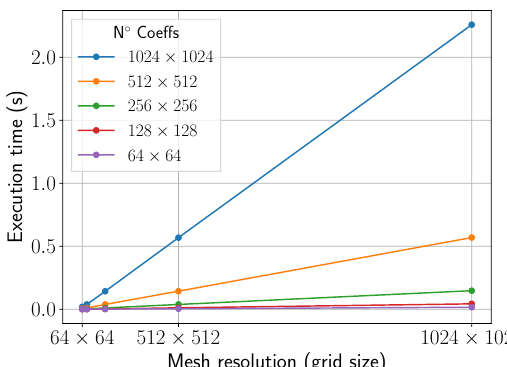
Figure 10. Execution times (s) for the computation of the temperature as the resolution (mesh size) increases. Results for different number of Fourier coefficients are